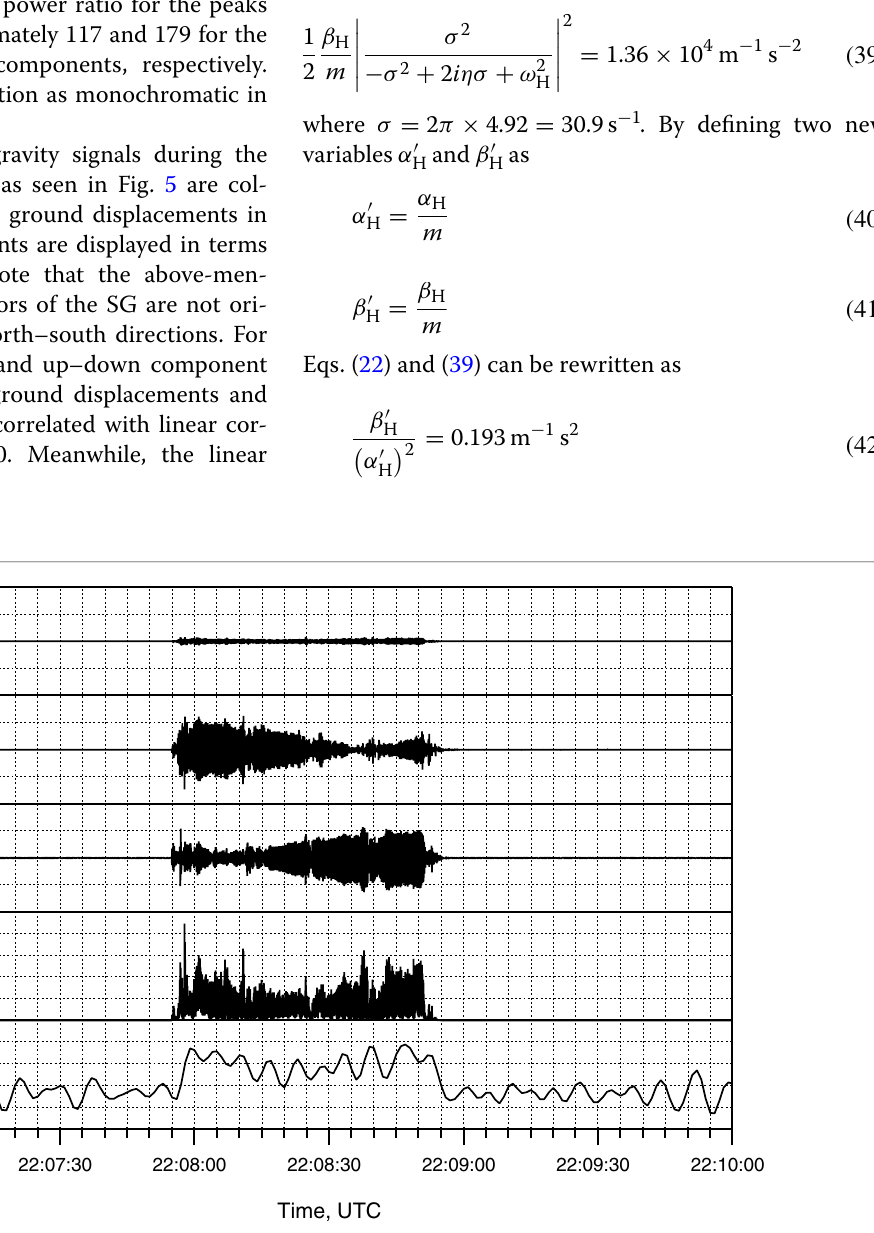
Fig. 5 Ground displacements caused by movements of the VLBI antenna recorded by a seismometer and the simultaneous offset in the gravity. UD, NS and EW denote the up–down, north–south and east–west components, respectively. (NS 2